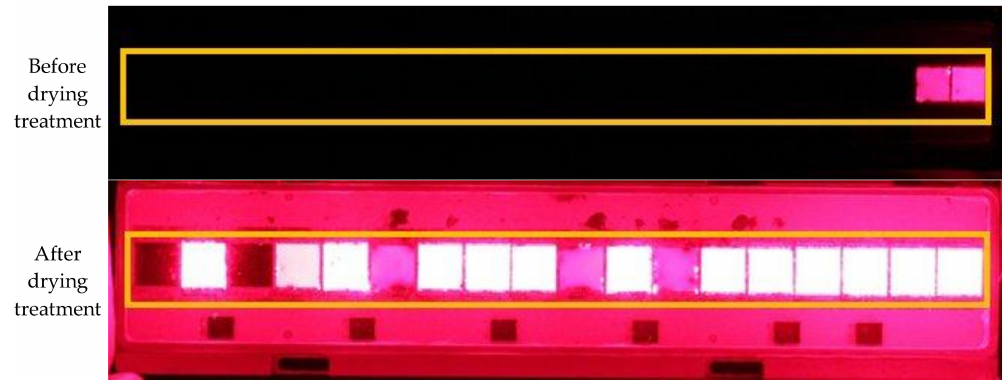
Figure 14. Electroluminescence test before and after the dehumidification treatment of the 203g11–2 module.